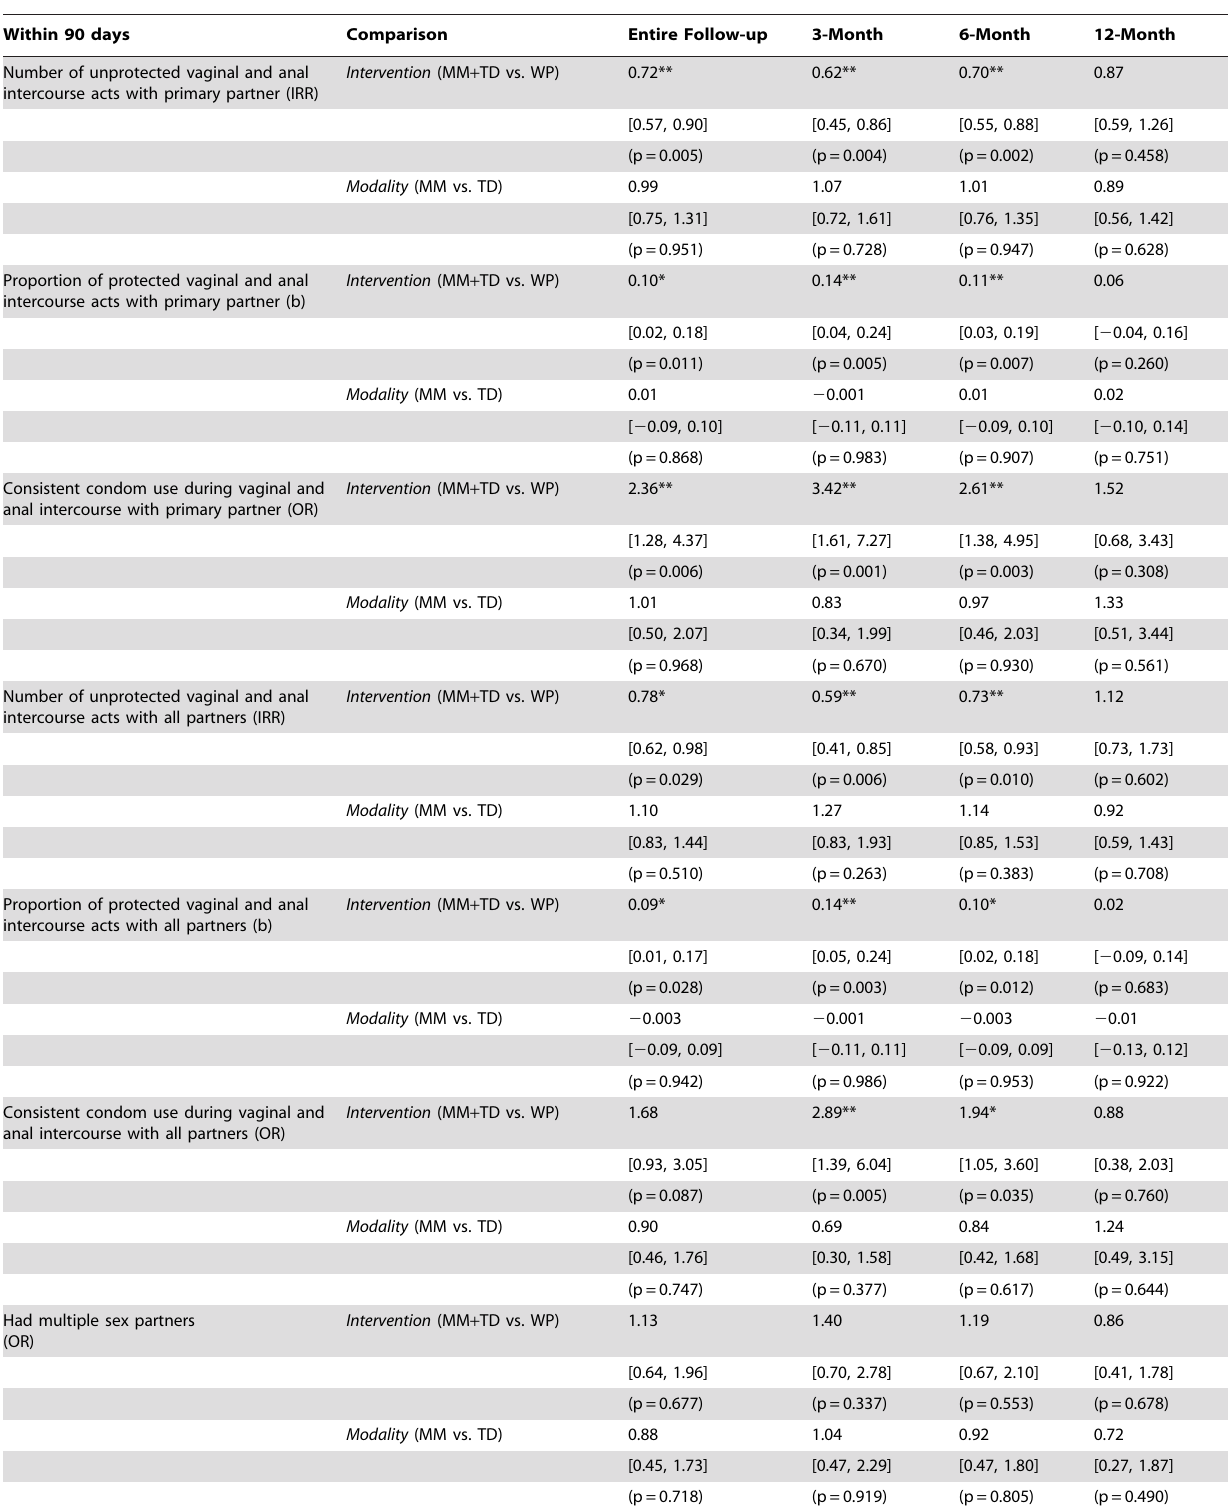
Table 3. Estimates of Intervention Effects on Sexual Risk Behaviors: Estimates, 95% Confidence Intervals and p-values.